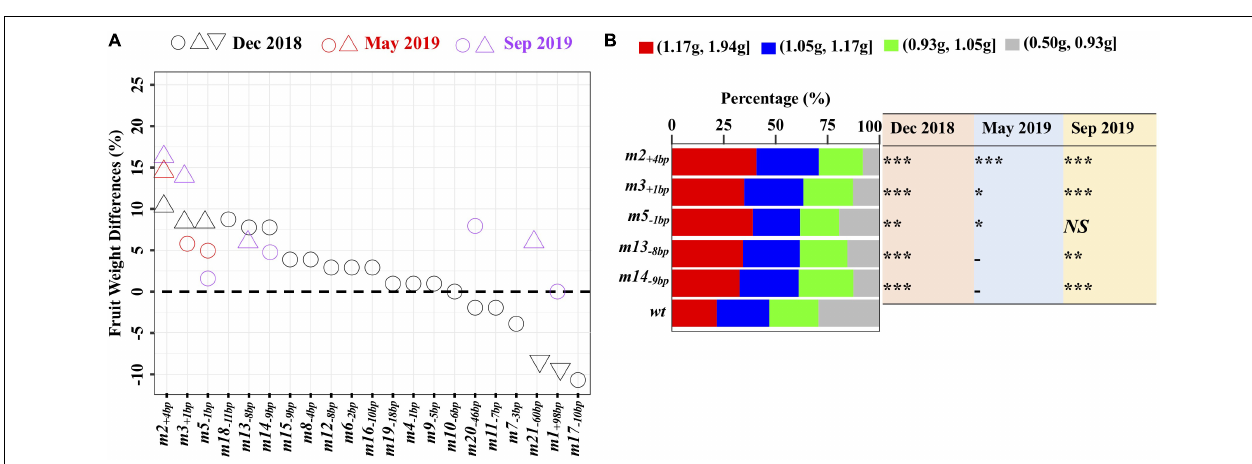
the weight of all fruits along inflorescence without affecting the decreasing